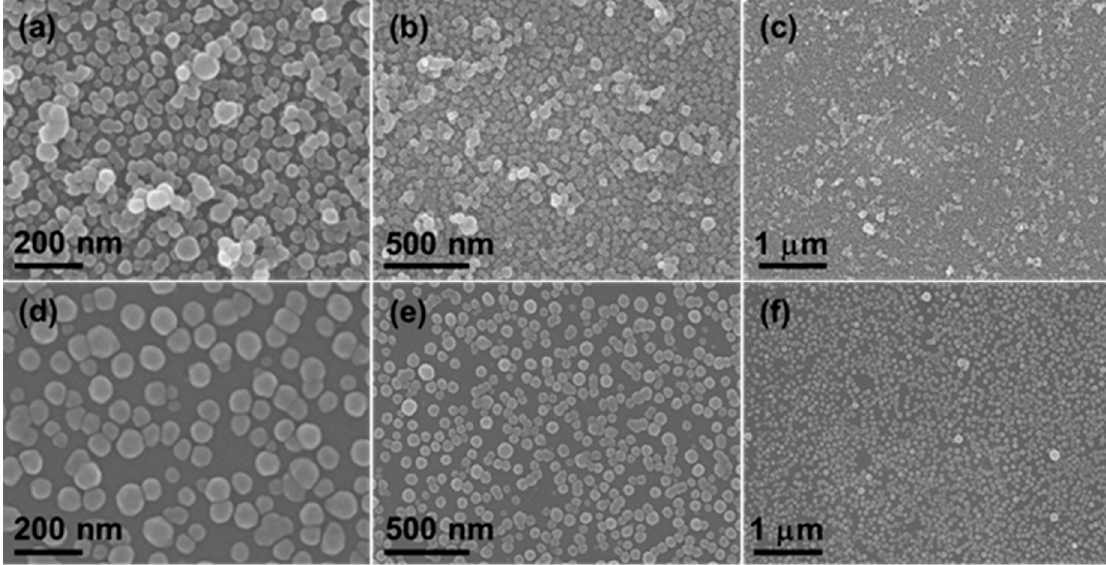
Figure 5. SEM images of CONPs from calcium oleate at different temperatures: ( a – c ) 600 °C and ( d – f ) 650 °C.